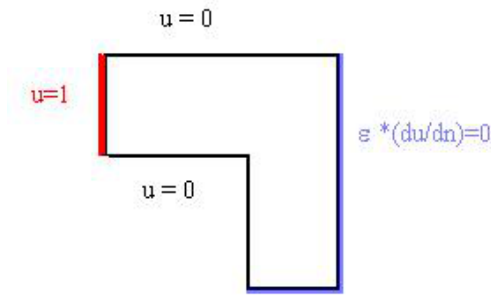
Figure 9. Boundary conditions for example 2.